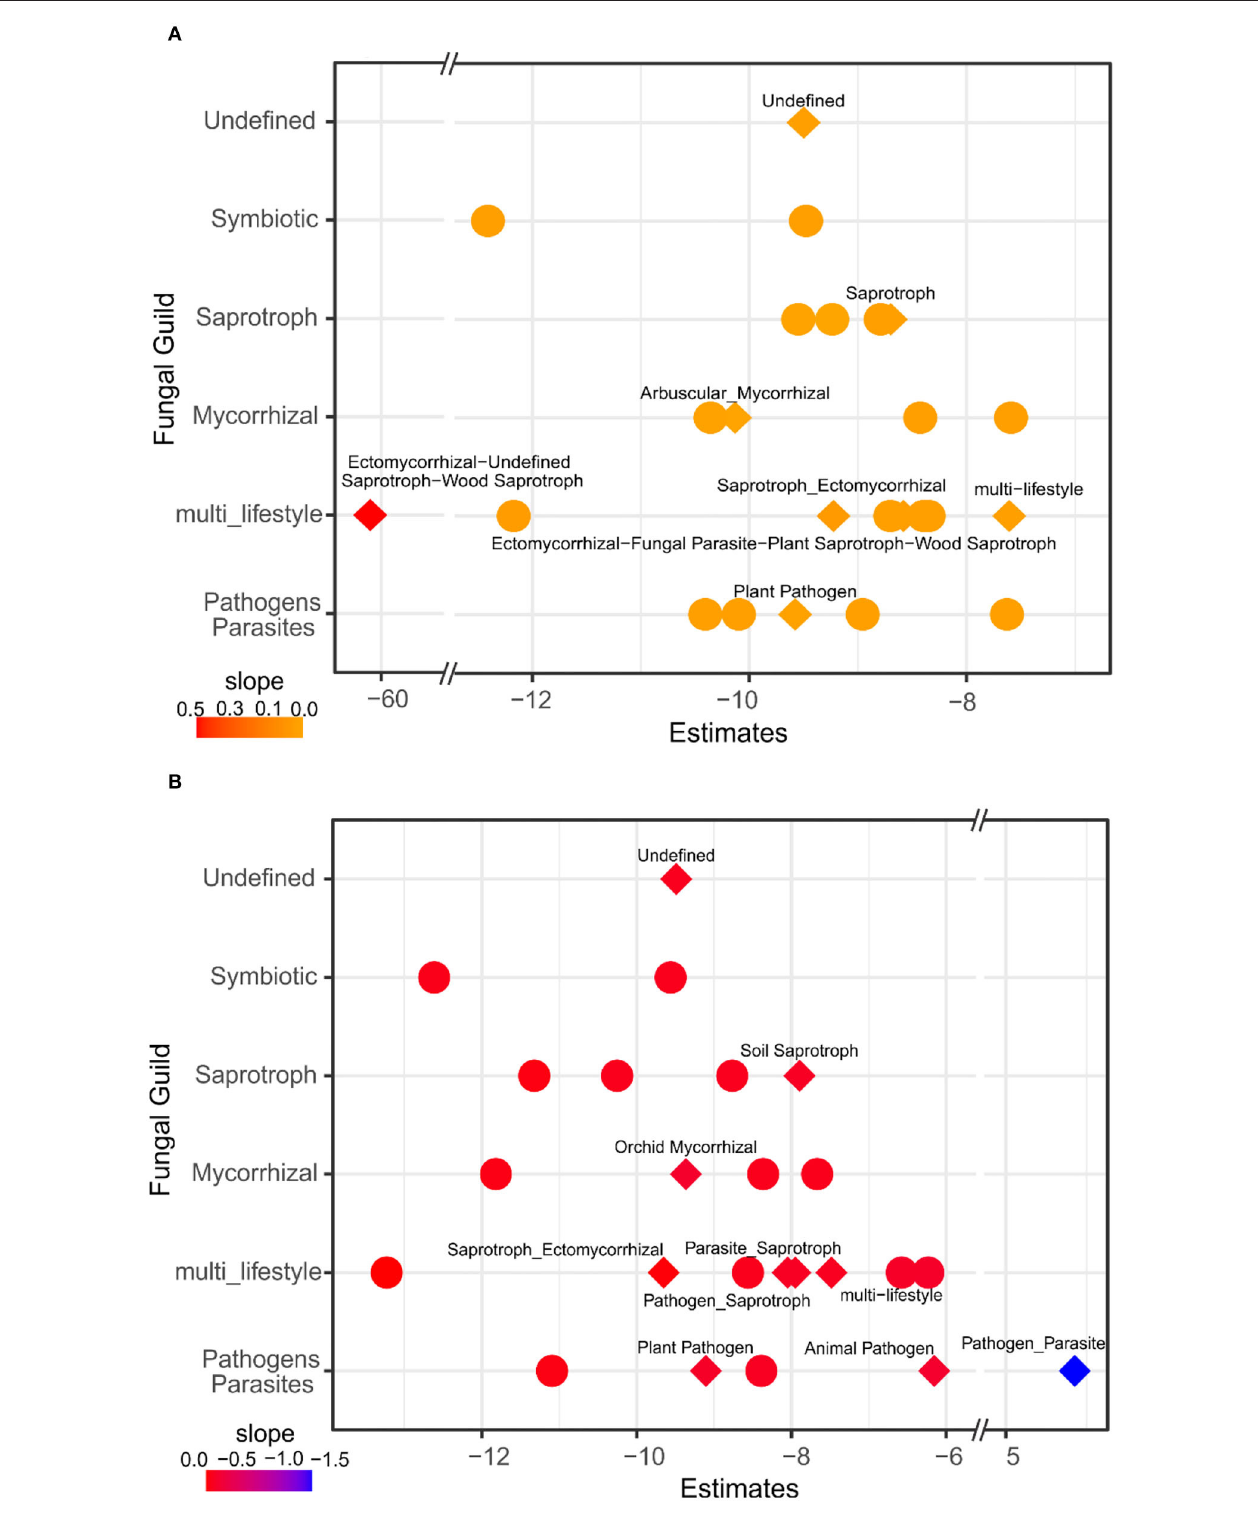
FIGURE 4 | GLM of fungal guilds related to evergreen tree proportion (A) and soil depth (B) . Estimates are the intercept of the model and the color represents the slope. Diamonds represent specific guilds that respond significantly according to ANOVA ( p < 0.05) of the GLM. Fungal guilds with significant effects in relation to evergreen tree proportion and soil depth were labeled with specific guilds (Guild 2), and model details are given in Supplementary Tables 9 , 10 .